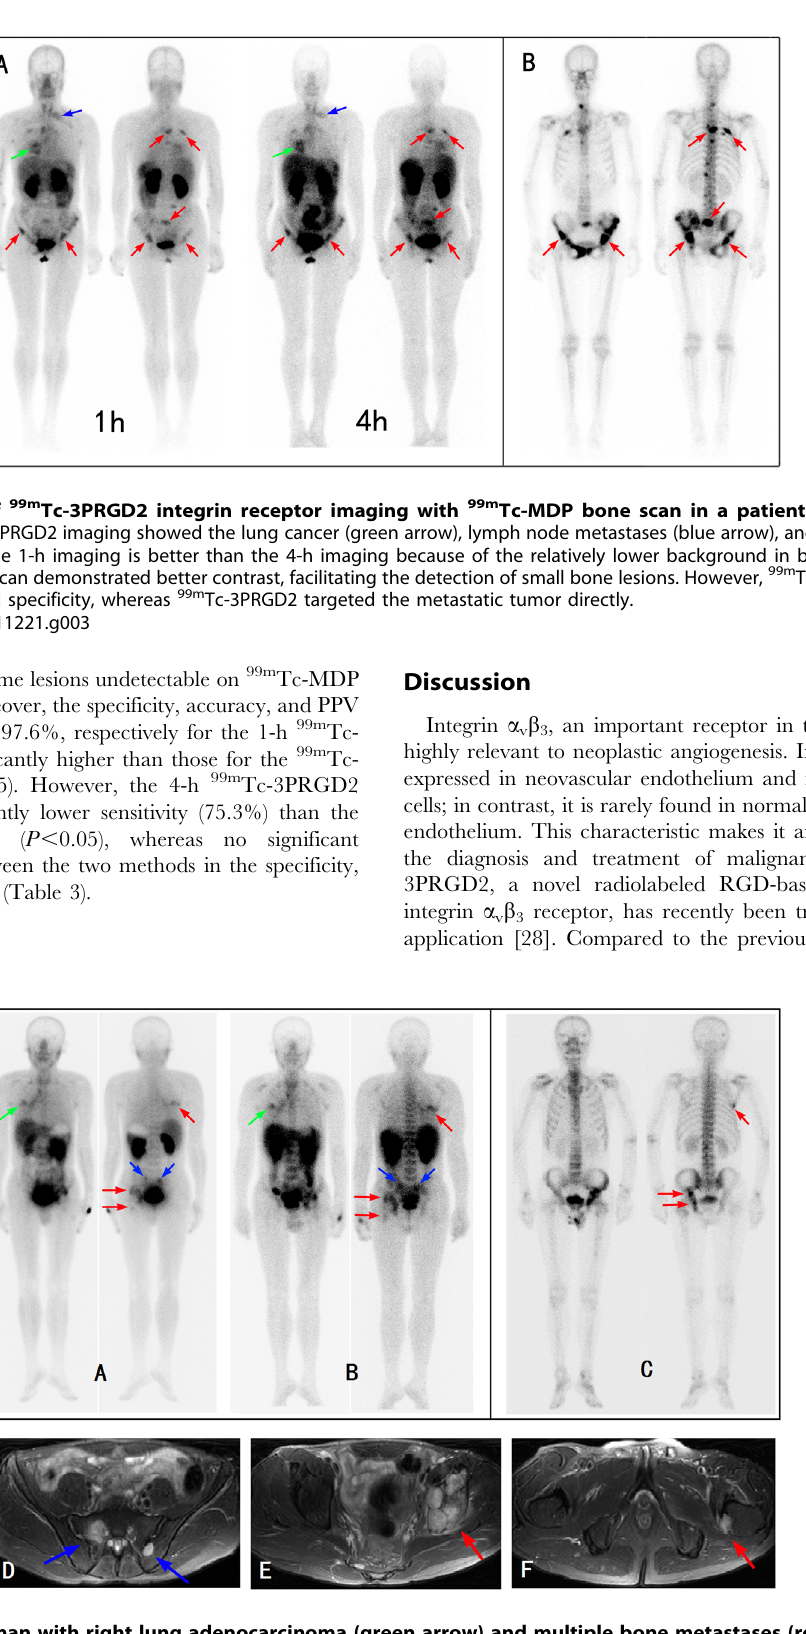
Figure 4. A 48 year-old man with right lung adenocarcinoma (green arrow) and multiple bone metastases (red and blue arrows). 99m Tc-3PRGD2 scans showed two more bone metastases (blue arrows) than the 99m Tc-MDP bone scan. The lesions were confirmed by MRI (lower row). A: 1-h 99m Tc-3PRGD2, B: 4-h 99m Tc-3PRGD2, C: 99m Tc-MDP, D–F: MRI.